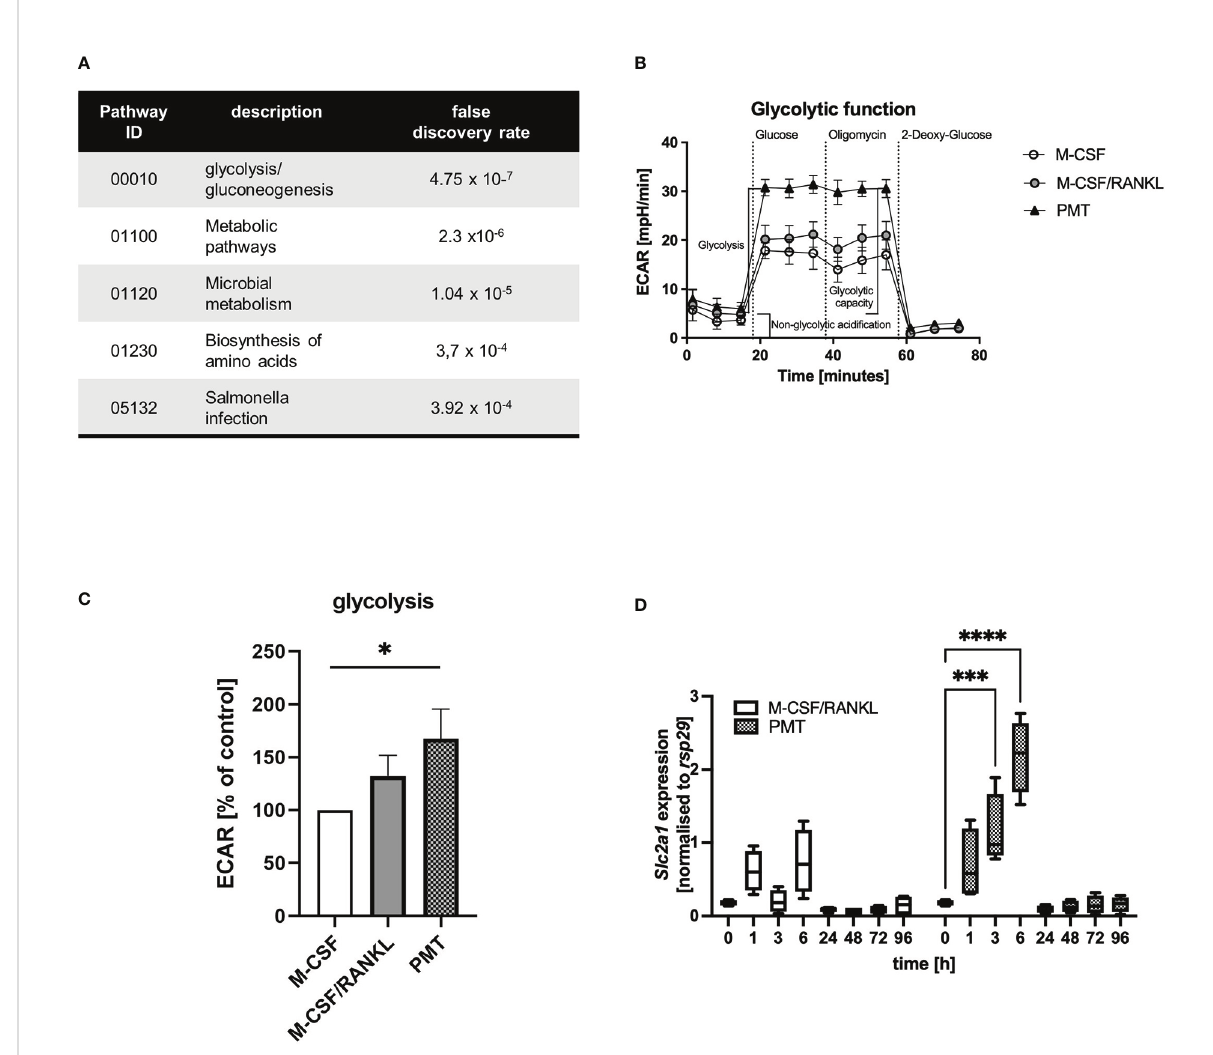
FIGURE 1 Comparison of osteoclast glycolytic activities during differentiation. (A) Proteins that were upregulated with PMT (10 most highly picked, results obtained for 7, see Supplementary Table) were subjected to a Panther GO analysis. (B, C) Glycolysis of BMDM differentiated for 3 days with M- CSF, M-CSF/RANKL or PMT was investigated in a Seahorse glycolysis assay with quanti fi cation of ECAR (n=3). ECAR results were normalised to the M-CSF-treated control. For statistical analysis a Friedman test was used on raw data. (D) BMDM were treated with M-CSF/RANKL or PMT and samples were taken at the indicated time-points to quantify the expression of Slc2a1 by RT-PCR (n=4). Statistical analysis was performed by 2-way